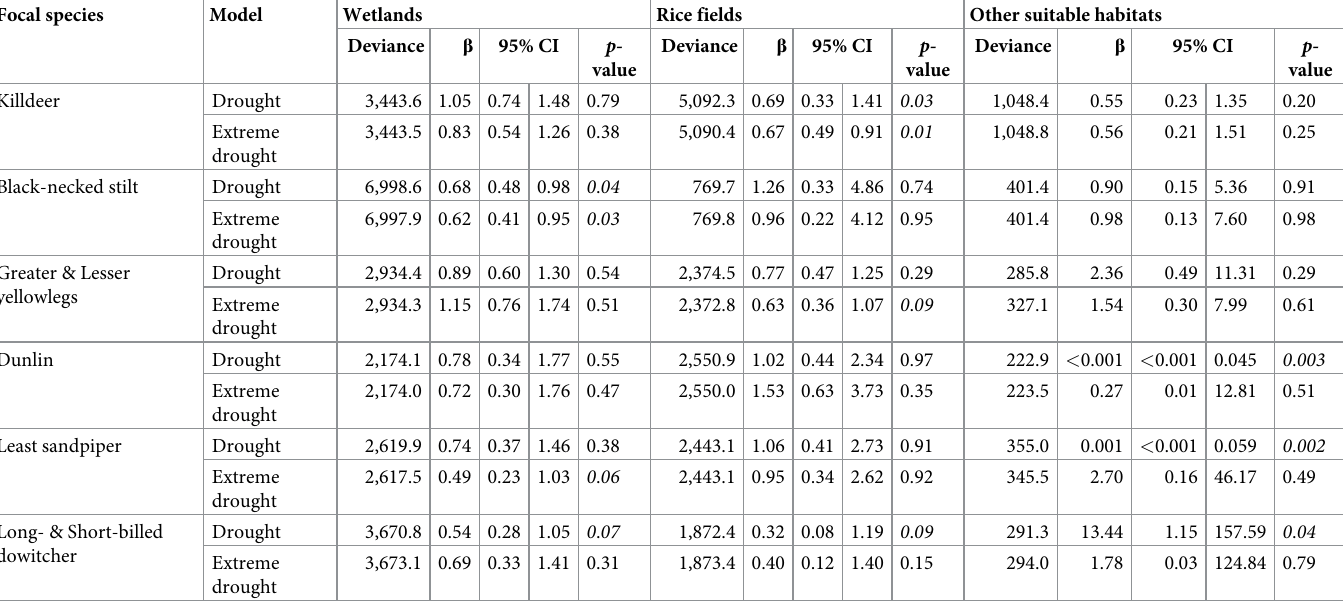
Table 1. Results of models of annual shorebird abundance among cover types in the Central Valley, California, USA. Focal